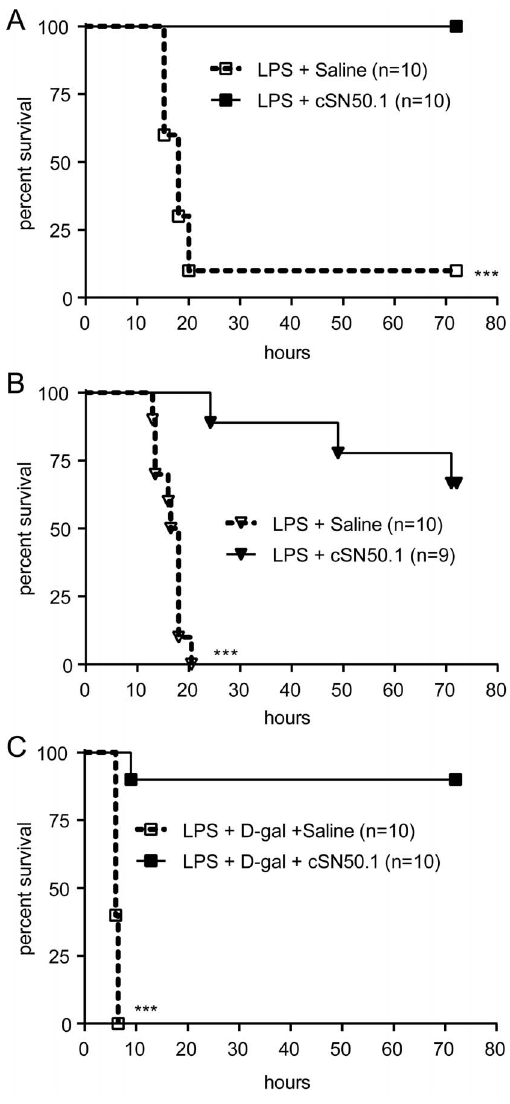
Figure 2. NTM treatment enhances survival from lethal endotoxic shock. Survival curves for mice challenged i.p. with high- dose LPS (A and B) or low-dose LPS + D-Gal (C). In (A) and (C) mice were administered the first NTM (cSN50.1 peptide) treatment 30 min before LPS challenge (prophylactic protocol), while in (B), the first treatment was administered 15 min after LPS challenge (therapeutic protocol). Saline injections were administered to control mice challenged with LPS following the same treatment schedule in each protocol, as described in ‘‘Materials and Methods’’. *** p , 0.0005 by log rank test.